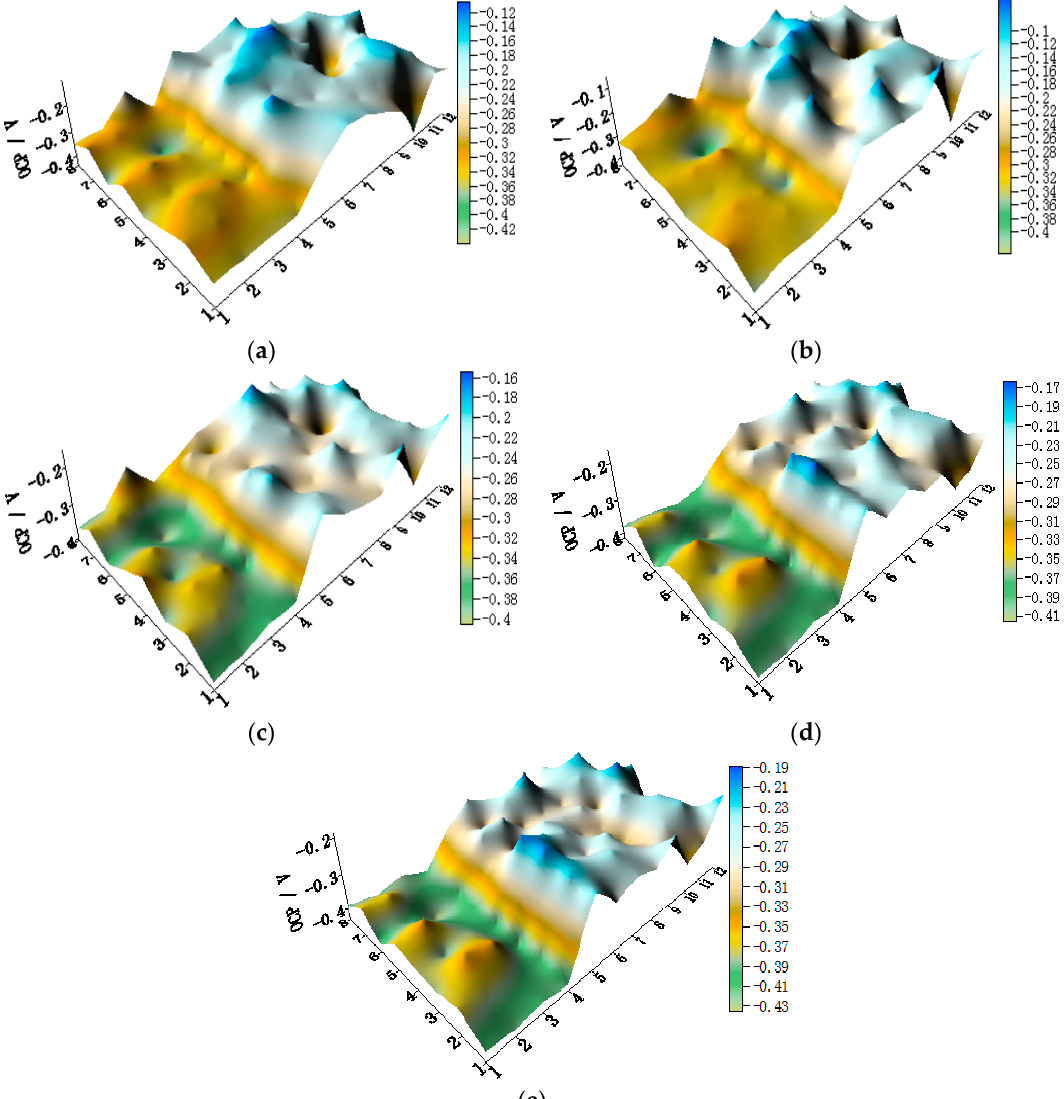
Figure 7. OCP (vs. SCE/V) distribution maps of the WBE2 after immersion in artificial seawater at different temperatures: ( a ) 30 °C; ( b ) 40 °C; ( c ) 50 °C; ( d ) 60 °C; and ( e ) 70 °C.